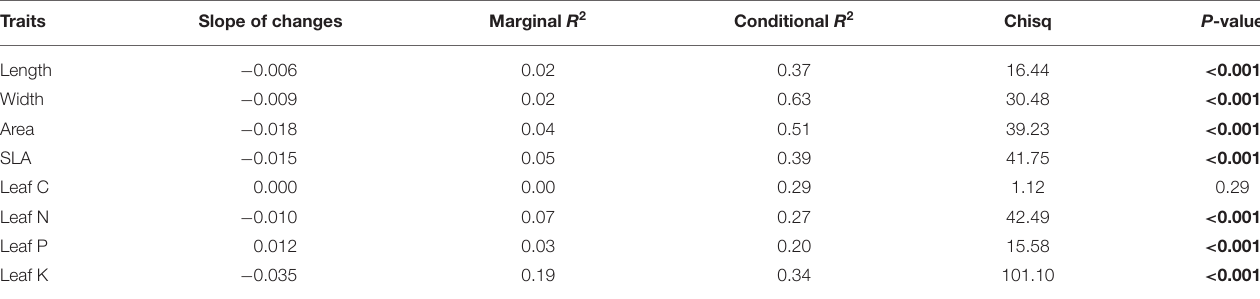
TABLE 1 | Changes in leaf functional traits along the urban–rural gradient across all the species studied, which was fitted with generalized linear mixed models, with traits as the response variable, distance of sites from the city center as the fixed effect, and species as the random intercept.